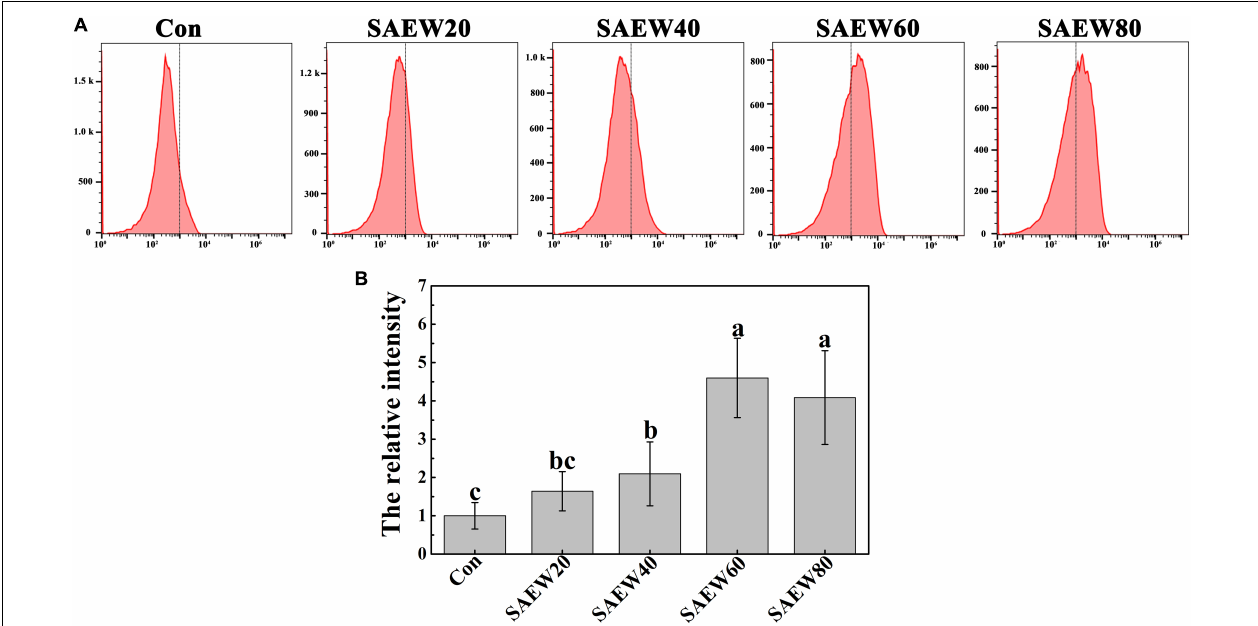
FIGURE 6 | The effect of SAEW on the ROS production in FON. (A) The DCF fluorescence of different treatments was measured by flow cytometry. (B) The relative intensity of DCF fluorescence was calculated by the ratio of different concentrations of SAEW to Con. Data are means ± SE from three independent experiments with 3 biological replicates for each ( n = 9). Different letters indicate significant differences at P < 0.05 according to the Duncan’s multiple range test. Con and control (deionized water); SAEW20 (20 ppm concentration of slightly acidic electrolyzed water); SAEW40 (40 ppm concentration of slightly acidic electrolyzed water); SAEW60 (60 ppm concentration of slightly acidic electrolyzed water); SAEW80 (80 ppm concentration of slightly acidic electrolyzed water); ROS: Reactive oxygen species; FON: Fusarium oxysporum f. sp. niveum